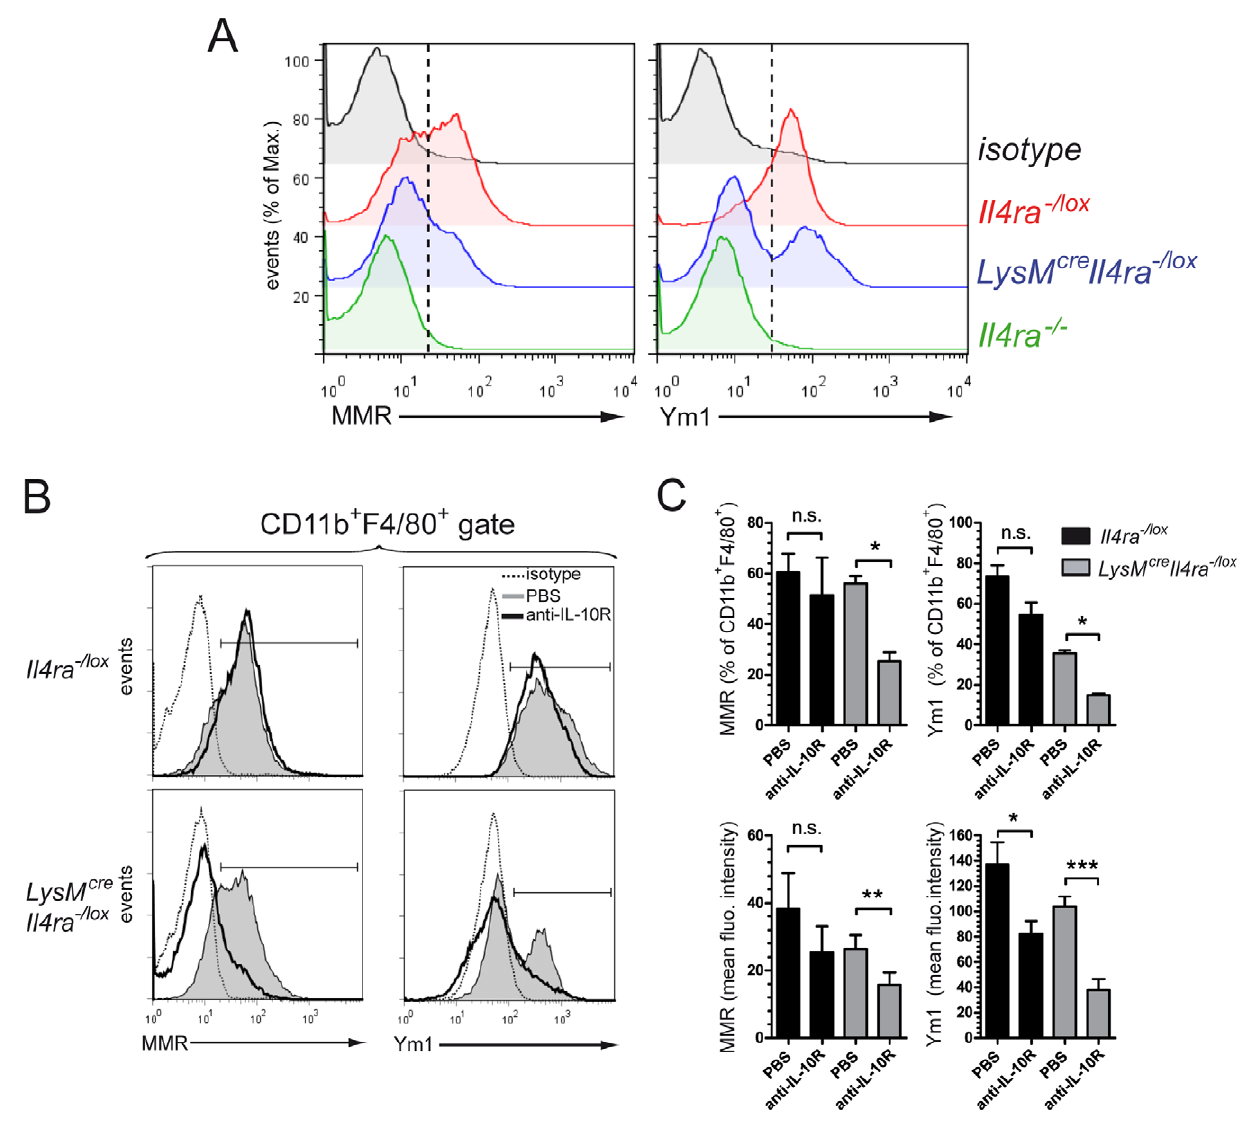
Figure 5. IL-10 signalling drives mannose receptor and Ym1 expression in macrophages independently of their IL-4R a expression. Peritoneal cells were harvested 7 days after injection of 3000 S. mansoni purified eggs in the peritoneum of Il4ra 2 /lox , LysM cre Il4ra 2 /lox or Il4ra 2 / 2 mice. (A) Representative histograms of macrophage mannose receptor (MMR) or Ym1 expression by peritoneal macrophages gated on FSC high SSC low CD11b + F4/80 + cells after exclusion of peritoneal eosinophils (FSC low SSC high CD11b + F4/80 + ) [37]. Black, isotype control; red, Il4ra 2 /lox ; blue, LysM cre Il4ra 2 /lox ; green, Il4ra 2 / 2 . Broken lines show threshold for positive signal. Data are representative of two independent experiments of pooled samples ( n =3). (B) Anti-IL-10 receptor treatment. Four mice out of eight in each group received 4 m g of anti-IL-10R i.p. at day 0, 4 and 6 post-injection. Overlays of representative monoparametric histograms of macrophage mannose receptor (MMR) or Ym1 expression by peritoneal macrophages are shown as described in A. Bracketed line indicates positive signal. Dotted line, isotype control; greyscale, untreated mice; bold line, mice treated with anti-IL-10R. (C) Percent and mean fluorescent intensities of peritoneal macrophages expressing MMR or Ym1 based on flow cytometry analysis in B. Data is representative of two independent experiments with mean 6 SEM ( n =3). * p , 0.05, ** p , 0.01, *** p , 0.001.